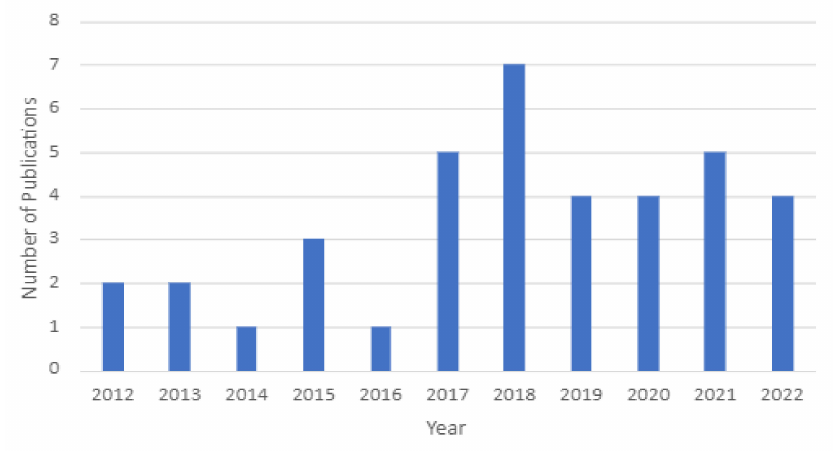
Figure 5. Number of selected articles published per year from 2012 to 2022.